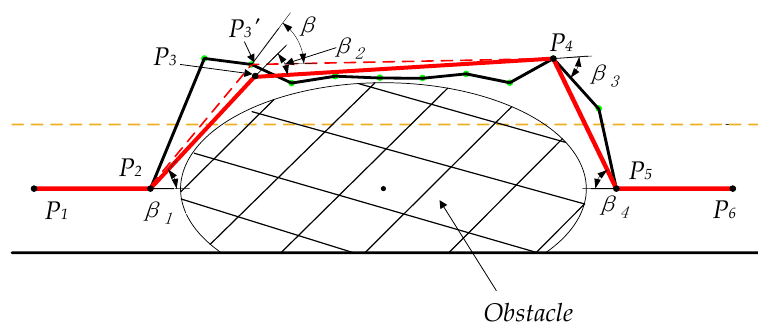
Figure 11. Path node reconnection processing.